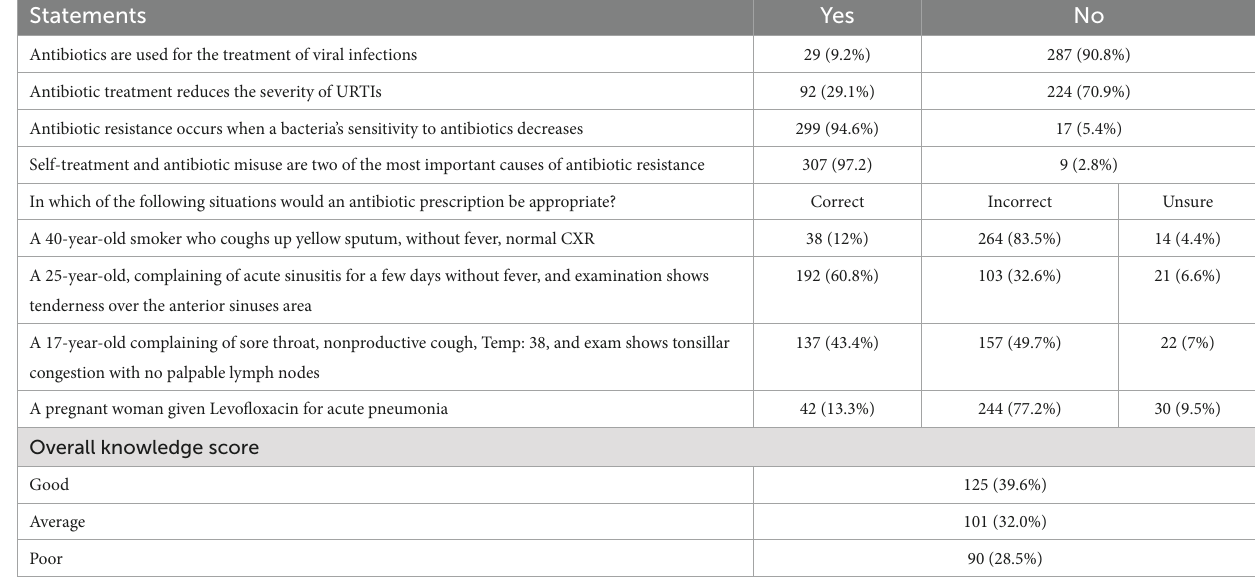
TABLE 2 Physician responses to questions about knowledge toward antibiotics.